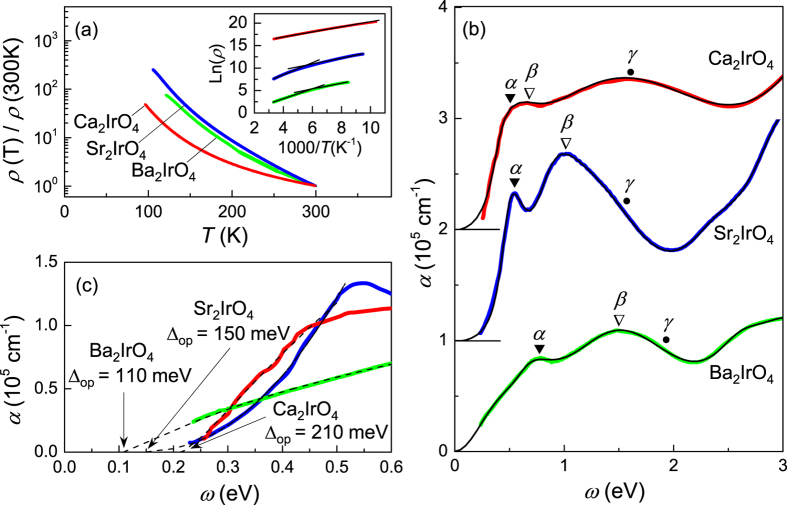
(a) Normalized resistivity (ρ) versus temperature data of Ca2IrO4 (red), Sr2IrO4 (blue) and Ba2IrO4 (green) thin-films. The data of Sr2IrO4 is from ref. 10; The inset shows the Arrhenius plot of Ca2IrO4, Sr2IrO4 and Ba2IrO4. Solid black lines present the linear fits at room temperature and low temperature. The estimated gap energies at room temperature are ΔCIO = 120 meV, ΔSIO = 250 meV, and ΔBIO = 190 meV. The Arrhenius plots are shifted vertically for clarity. (b) Optical absorption spectra (α (ω)) of Ca2IrO4, Sr2IrO4 and Ba2IrO4 thin-films at room temperature. The plots are shifted vertically by 105 cm−1 for clarity. The α, β and γ represent the optical transition peak energies obtained from the fit with the minimal set of the Lorentz oscillators. The solid black curves are the fit curves using Lorentz oscillators, which match well with the experimental spectra. (c) Fitted absorption spectra of Ca2IrO4, Sr2IrO4 and Ba2IrO4 at low energy using Wood-Tauc’s method21 which clearly confirm the increased energy gap from Ba2IrO4 to Ca2IrO4. The estimated optical gap energies using this method are ΔCIO = 210 meV, ΔSIO = 150 meV, and ΔBIO = 110 meV.